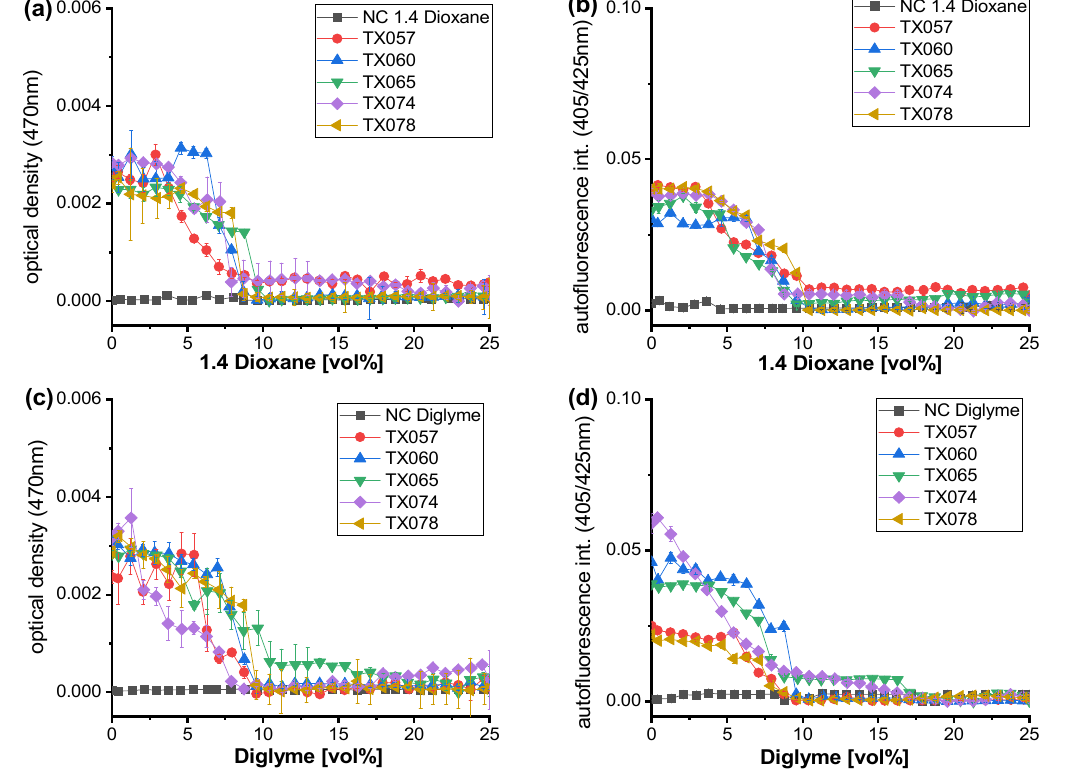
Figure 8. Dose-response curves of isolated Achromobacter spanius strains TX057, TX060, TX065, TX074 and TX078 against 1,4-Dioxane ( a , c ) und Diglyme ( b , d ). a and c show the optical density of the segments measured by microphotometry, b and d show the normalized autofluorescence intensity of the segments measured by microfluorimetry. Each dot represents the mean and the error bars represent standard deviation of 10 ± 3 droplets.